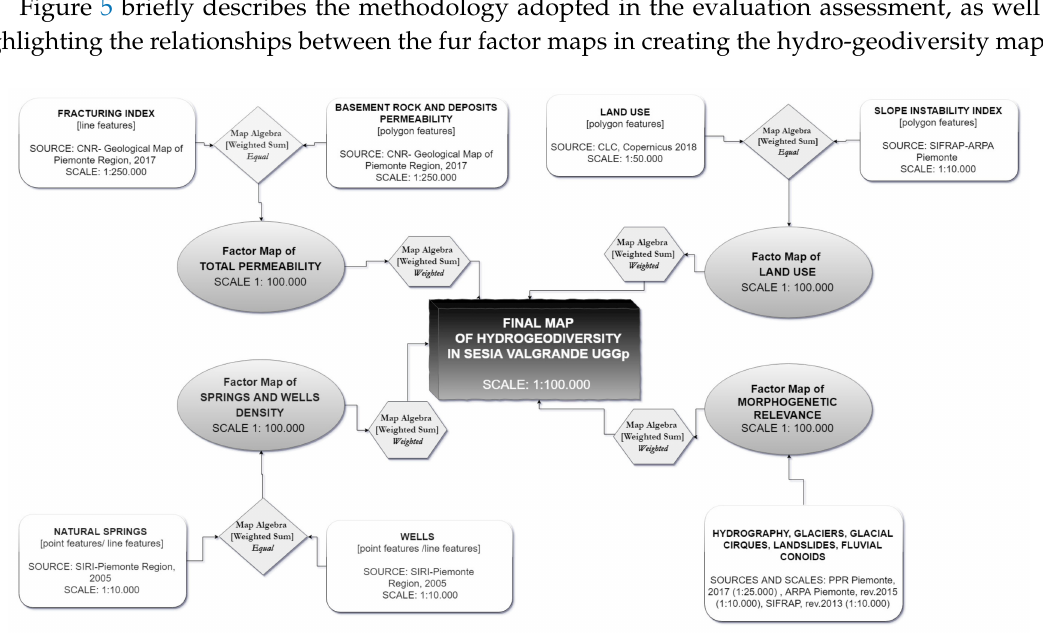
Figure 5. Flow diagram for the creation of the final map of hydro-geodiversity in the Sesia Val Grande UNESCO Global